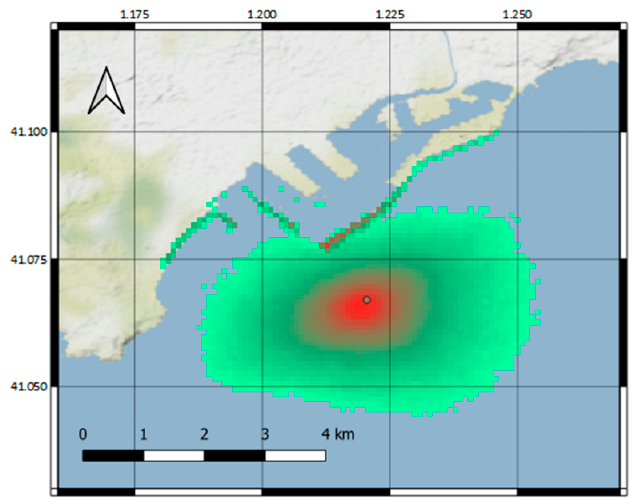
Figure 5. IPM for spills in the monobuoy (brown dot), evaluated on the port domain.